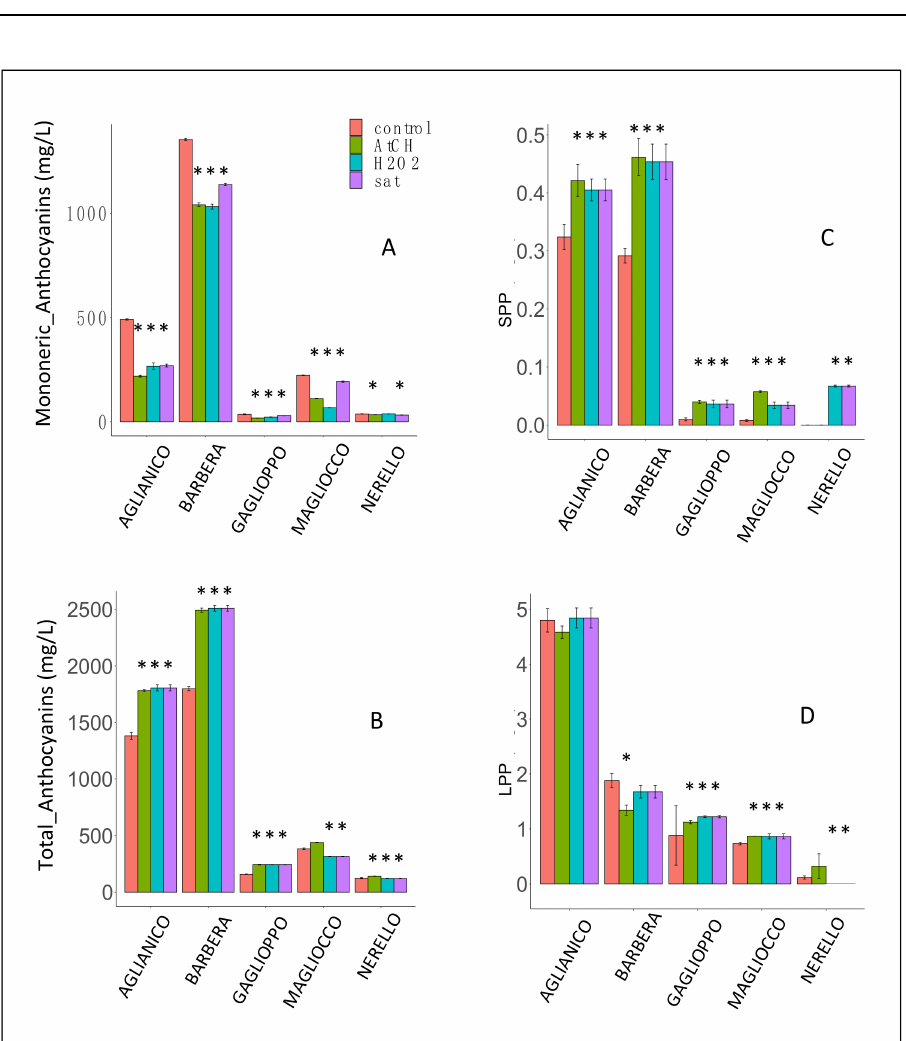
Figure 1. Variation of pigments in response to oxidative tests in different wines (Aglianico; Barbera; Gaglioppo; Magliocco; Nerello; Mascalese). ( A ) Sum of monomeric anthocyanins; ( B ) total antho- cyanins; ( C ) polymeric pigments with a low degree of polymerization; ( D ) polymeric pigments with a high degree of polymerization. Asterisks (*) indicate significant differences between treated wine and its control ( p -value less than